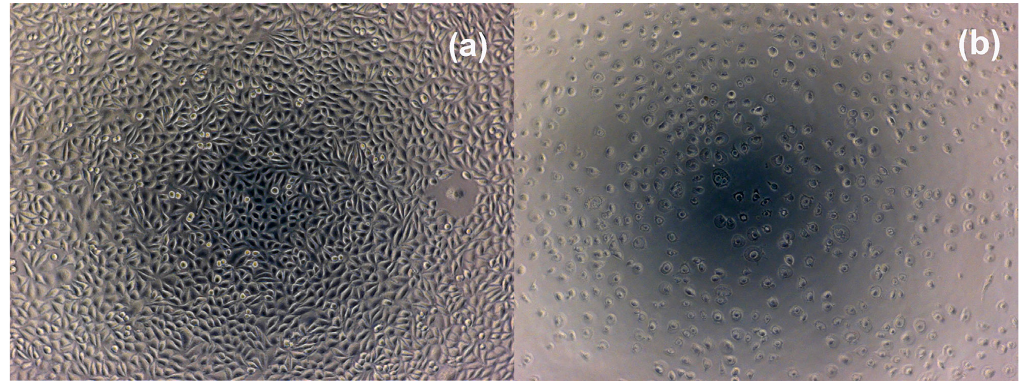
Figure 9. Viable L929 cells on SDS concentrations of 10μg/mL (a) and 100μg/mL (b).